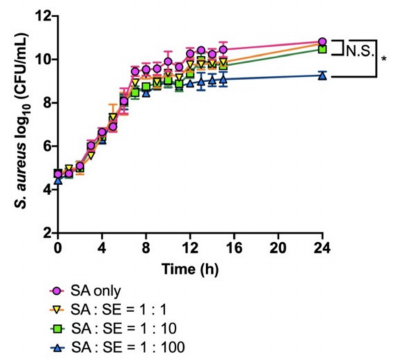
Figure 2. Growth of S. aureus SA-1 co-cultured with S. epidermidis SE-4. The culture was started with ~10 4 CFU/mL of S. aureus SA-1 and appropriate amounts of S. epidermidis SE-4. The number of S. aureus SA-1 was determined by colony counting on LB plates with LVFX. The data are presented as the mean ± SD of at least three independent experiments. The detection limit was 4.0 × 10 2 CFU/mL. Student’s t -test was used to determine a significant difference between the absence and presence of S. epidermidis SE-4 (*, p < 0.05). N.S.; not significant.